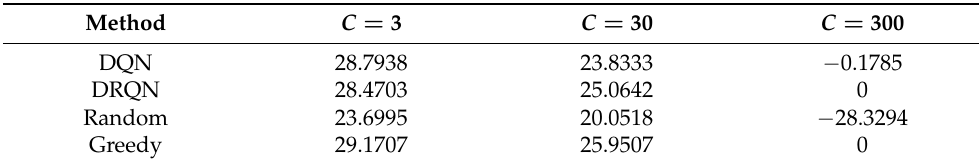
Table 3. The reward after 200,000 steps under different C (Single